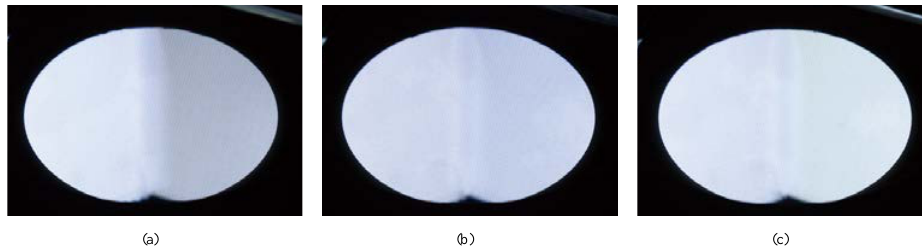
Figure 8. Effects of brightness matching technique: ( a ) without brightness matching, with brightness matching using ( b ) quarter-wave plates, and ( c ) hale-wave plates.